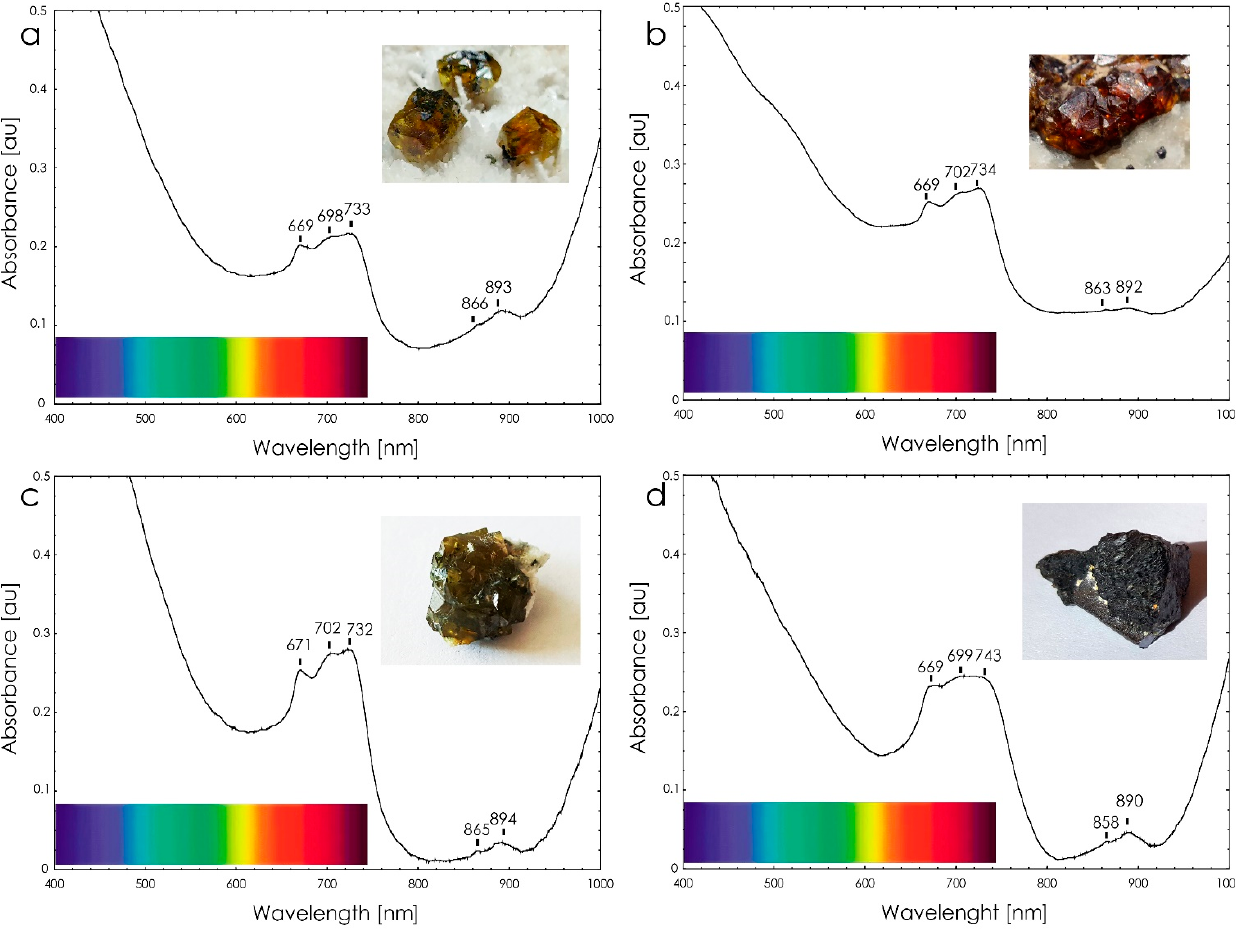
Figure 5. Optical spectra of studied sphalerite samples: ( a ) yellow sphalerite—sample A; ( b ) orange sphalerite—sample B; ( c ) olive-green sphalerite—sample C; ( d ) black sphalerite—sample D. Minimum absorption is in the yellow, orange-red part of the visible spectrum giving rise to the crystals’ yellowish-orange and orange-red color (Figure 5a,b). On the other hand, absorption in the red region for olive-green sphalerite (Figure 5c) is more pronounced compared to yellowish-orange and orangy-red sphalerites, explaining the shift of the color to greenish hues. In the case of black sphalerite, the absorption pattern is similar to the olive-green sphalerite; however, the bands in the 644 (15,527 cm − 1 ) to 740 nm (13,513 cm − 1 ) region are less defined, creating one wide band (Figure